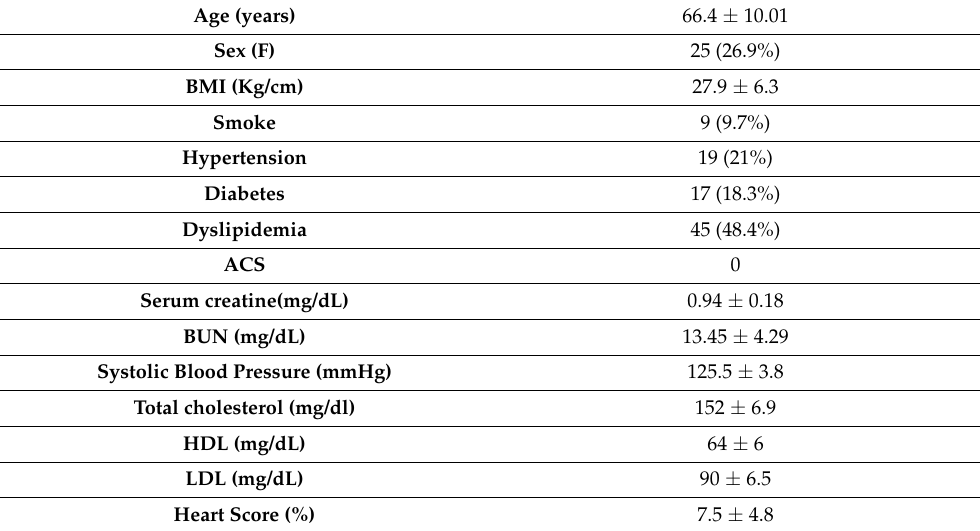
Table 1. Characteristics of the study population (93 patients). Data are reported as mean ± SD for continuous variable and as absolute value and percentage for categorical